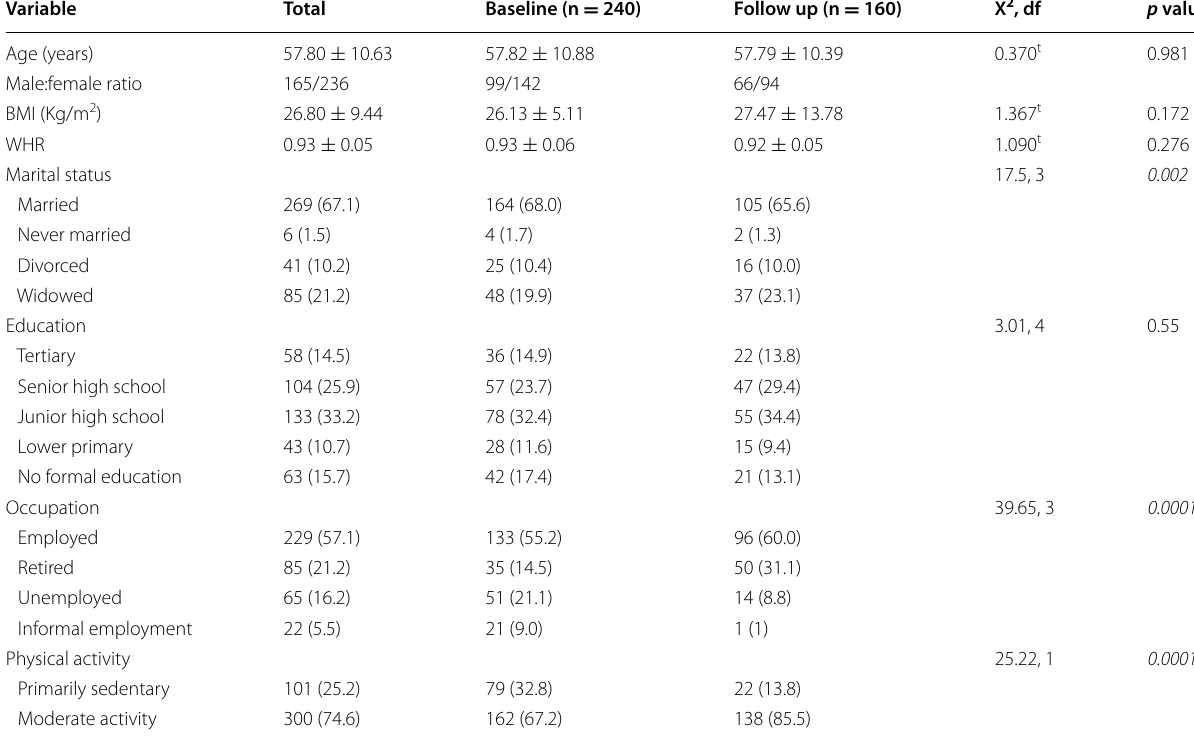
Values are presented as frequency (percentage); mean t t-test value